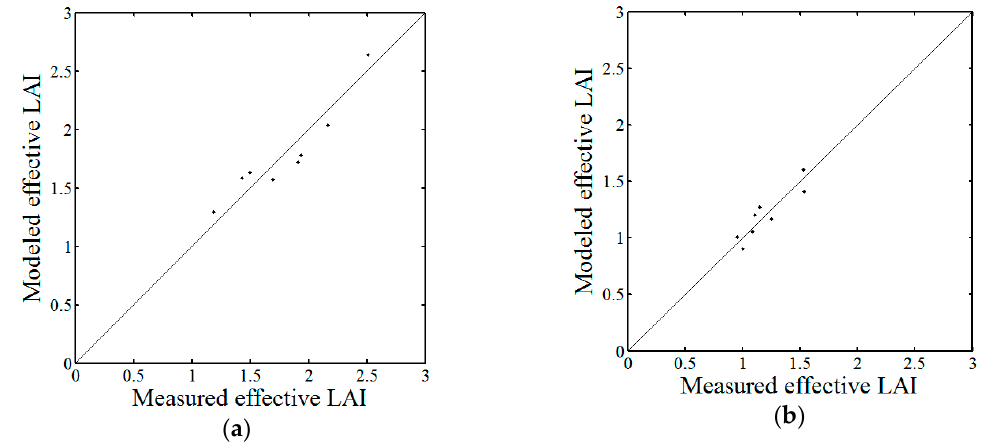
Figure 10. Validation of effective LAI retrieval at Dayekou ( a ) and Saihanba ( b ).